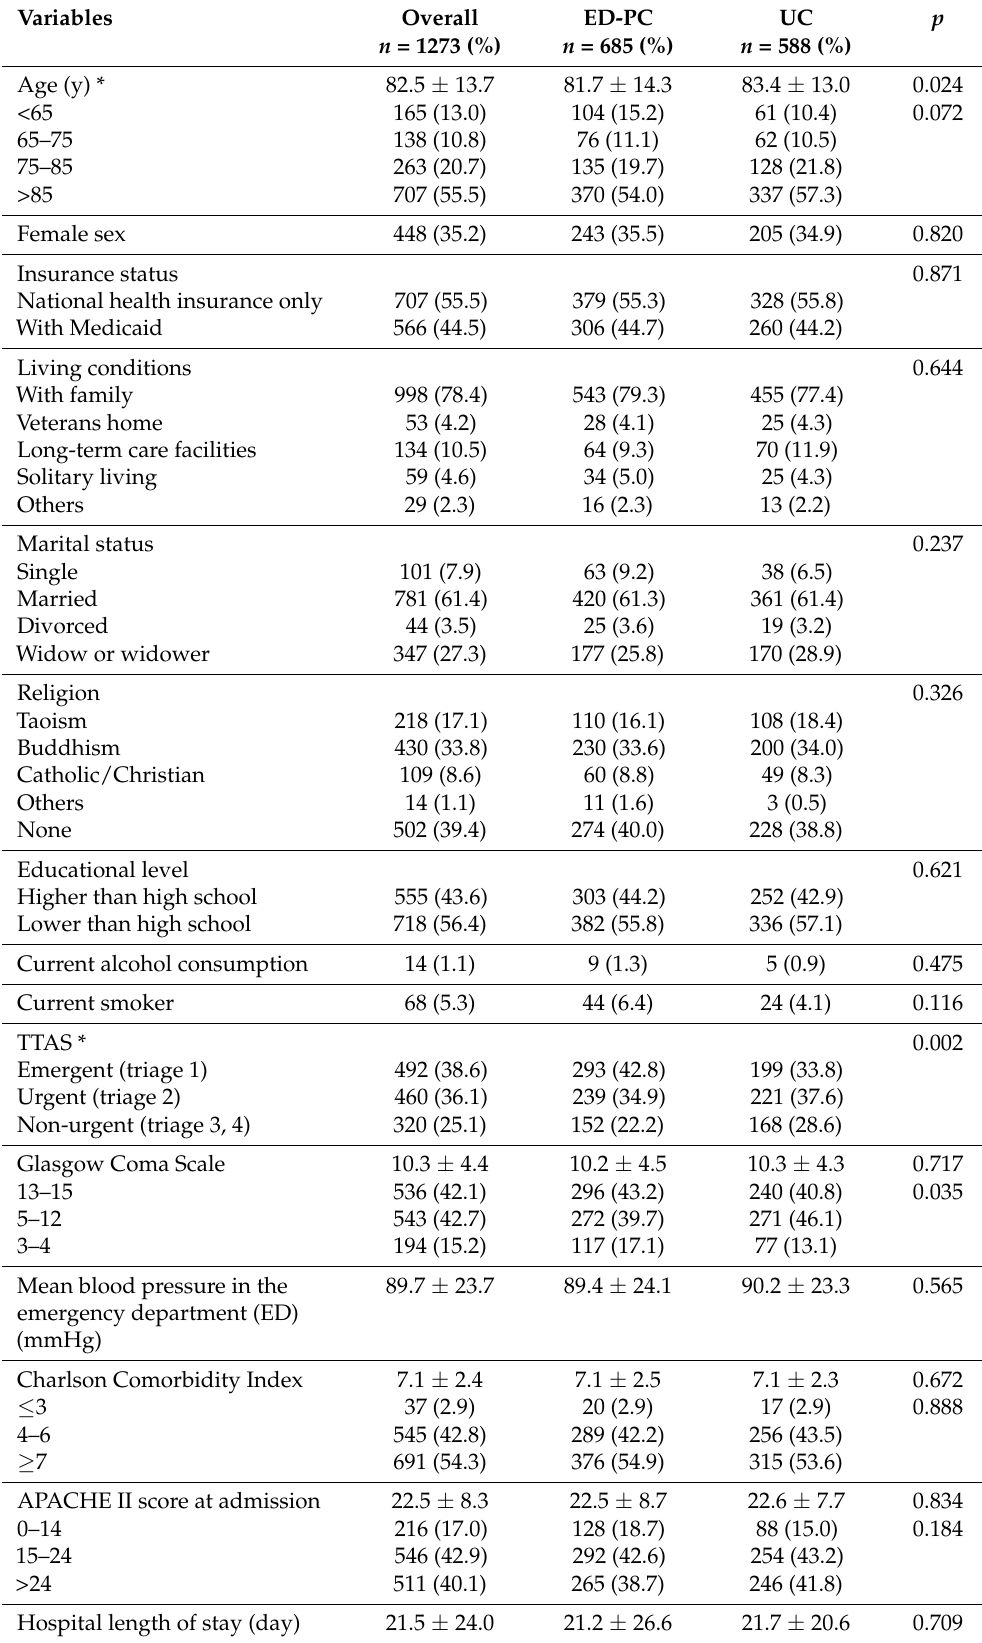
Table 2. Comparison of the clinical characteristics between patients with ED-PC and